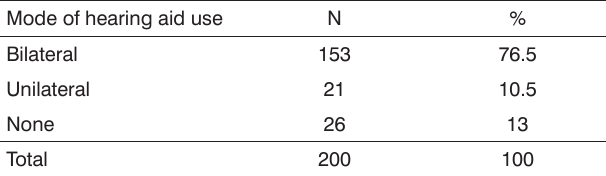
Table 1. Frequency and percentage frequency distribution of mode of hearing aid use.